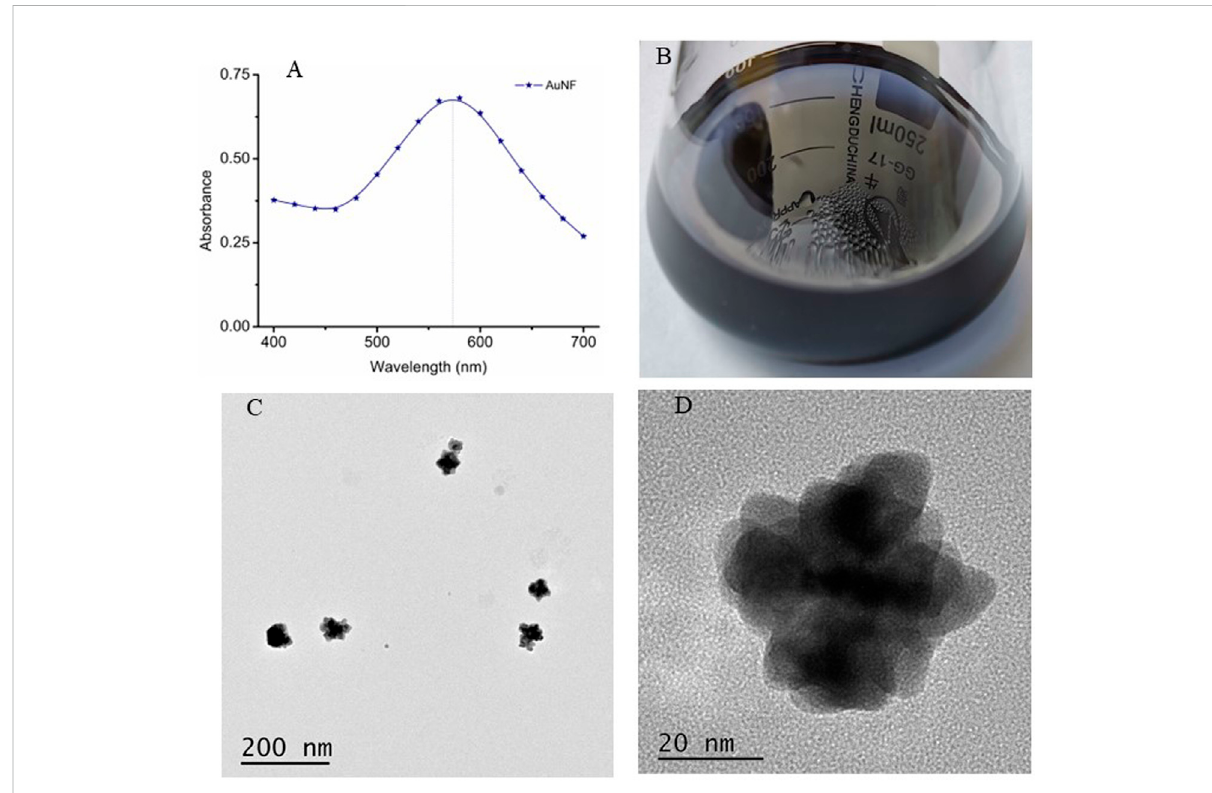
FIGURE 4 PreparationandcharacterizationofAuNFnanoparticles. (A) UV-VISspectrumscanningofAuNF. (B) ThepreparedAuNFsolution. (C) TEMimage of the AuNF at the scale of 200 nm. (D) TEM image of the AuNF at the scale of 20